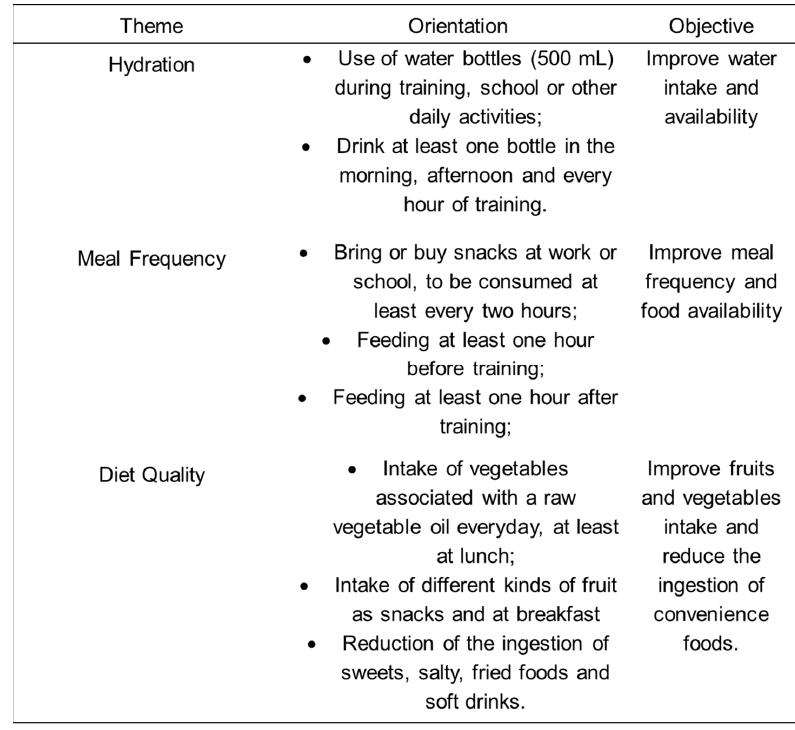
Figure 2. Issues addressed in the consultations.